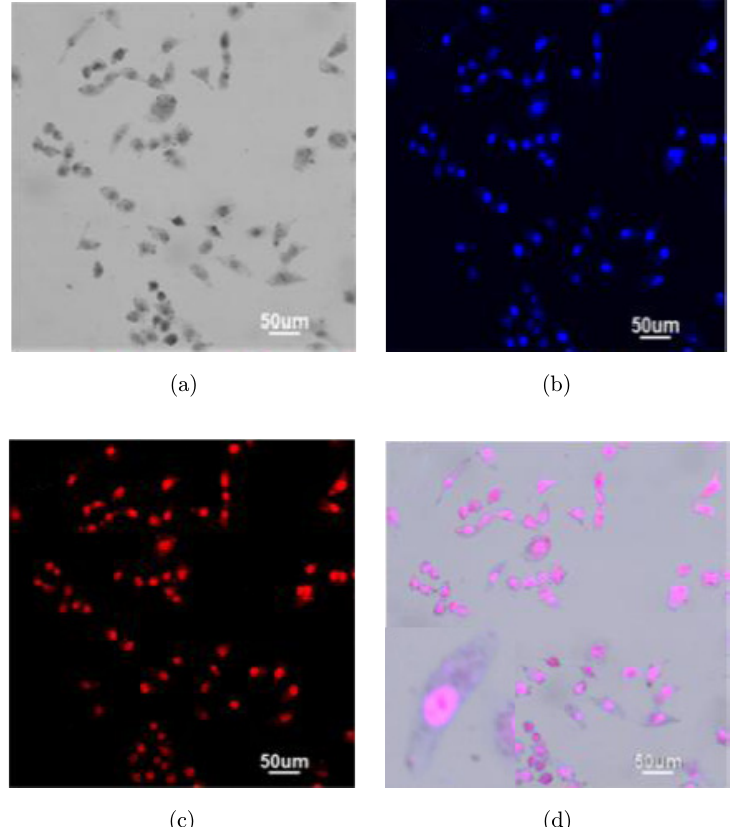
Fig. 3. Optical microscopy of live A549 cells incubated with QDs (a) di®erential interference contrast (DIC), (b) hoechst, (c) QDs, (d) the merged image of the °uorescence images and DICimage. (cid:2) ex ¼ 488 nm. (inset: cell imaging with higher